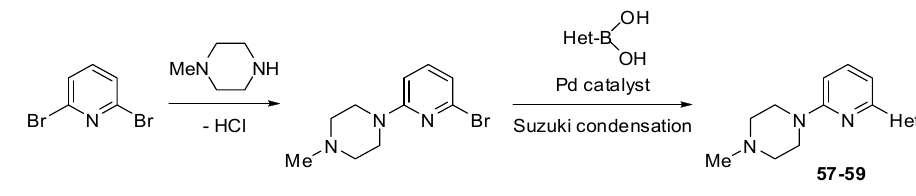
Scheme 8. Synthesis of substituted pyridines 57 – 59 (see Table 4).